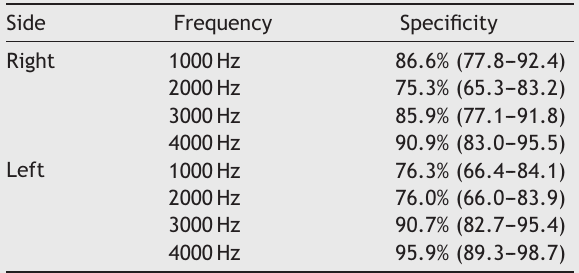
PR test specificity in evaluated frequencies in 105 newborns